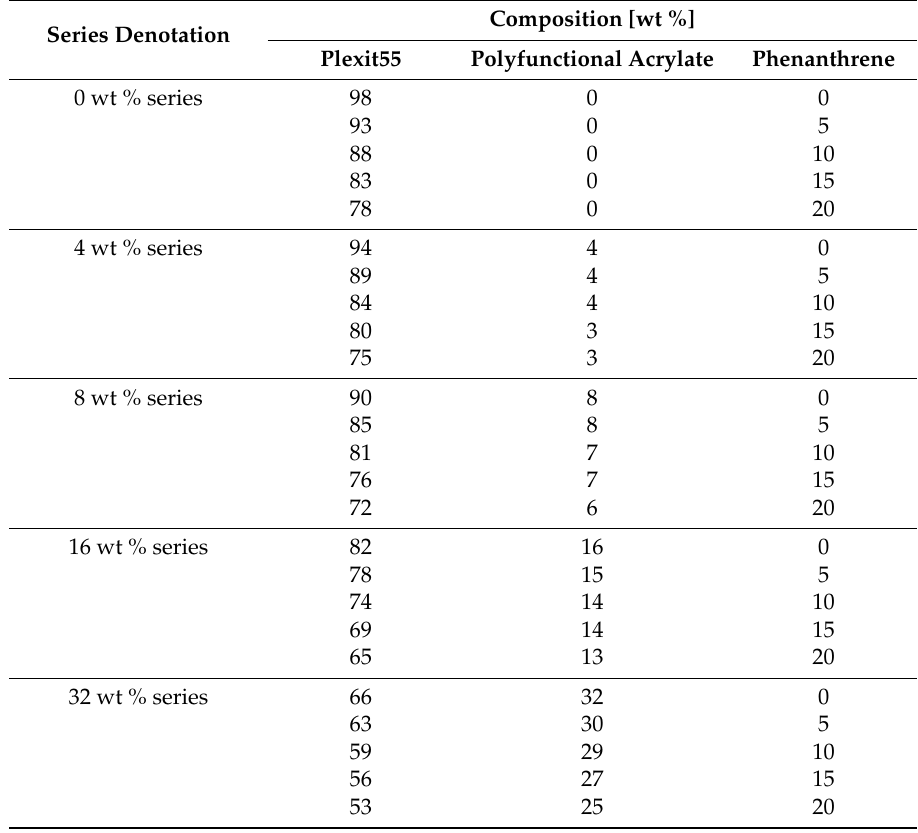
Table 1. Sample series denotation and related mixture composition (in round figures to 100% without decimal place) All mixtures contain in addition 1 wt % thermal initiator DLP and release agent INT54